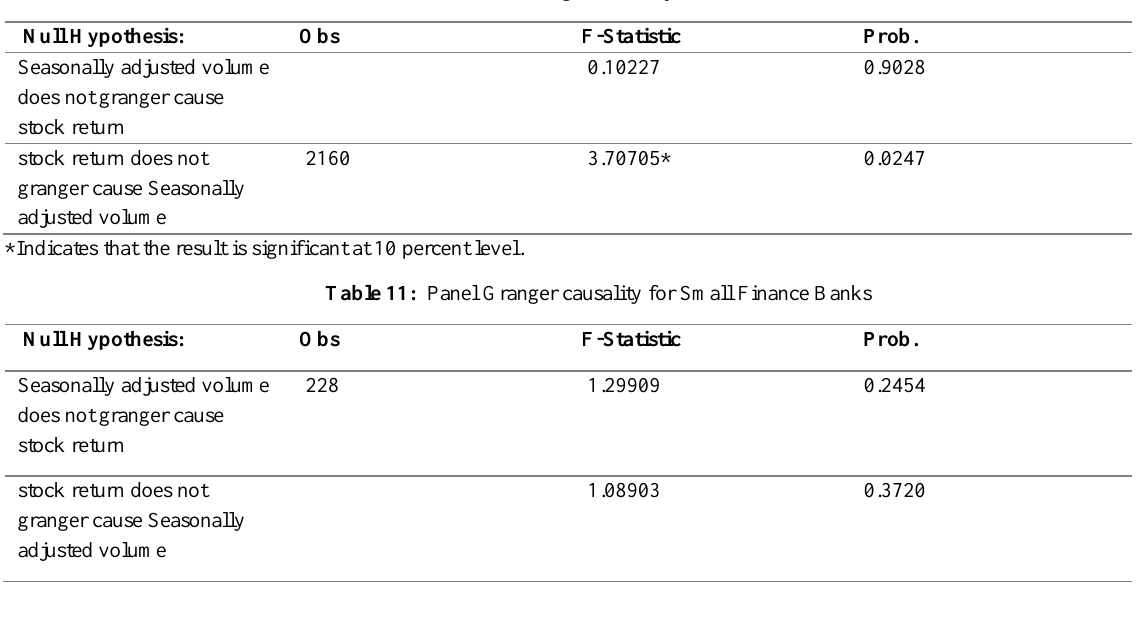
Table 10: Panel Granger causality for Private Banks